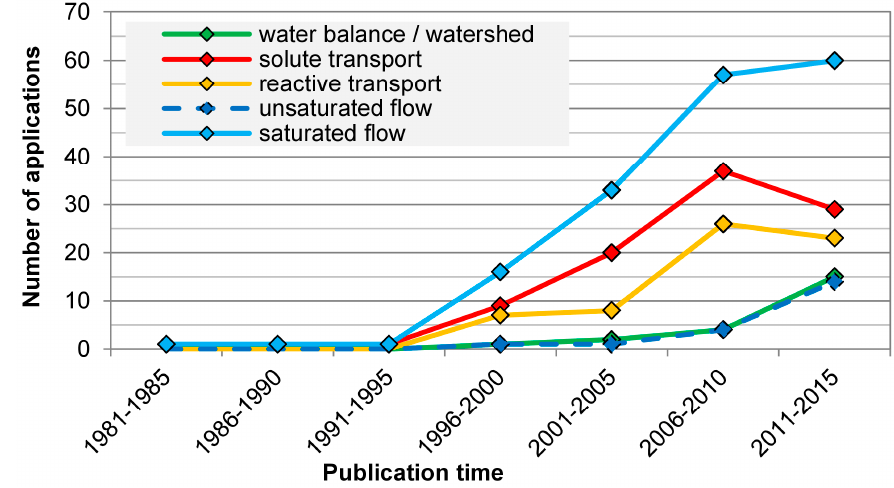
Figure 2. Historical development of different model types (literature studies may involve multiple or combine different model types).